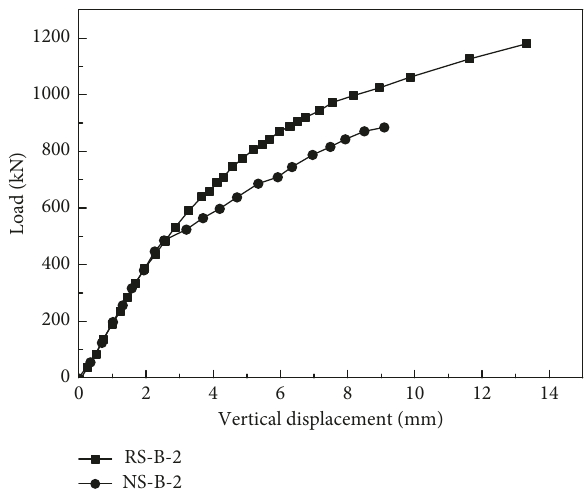
Figure 9: Comparison of reinforced and unreinforced CFST piles with thickness is 1.6mm.